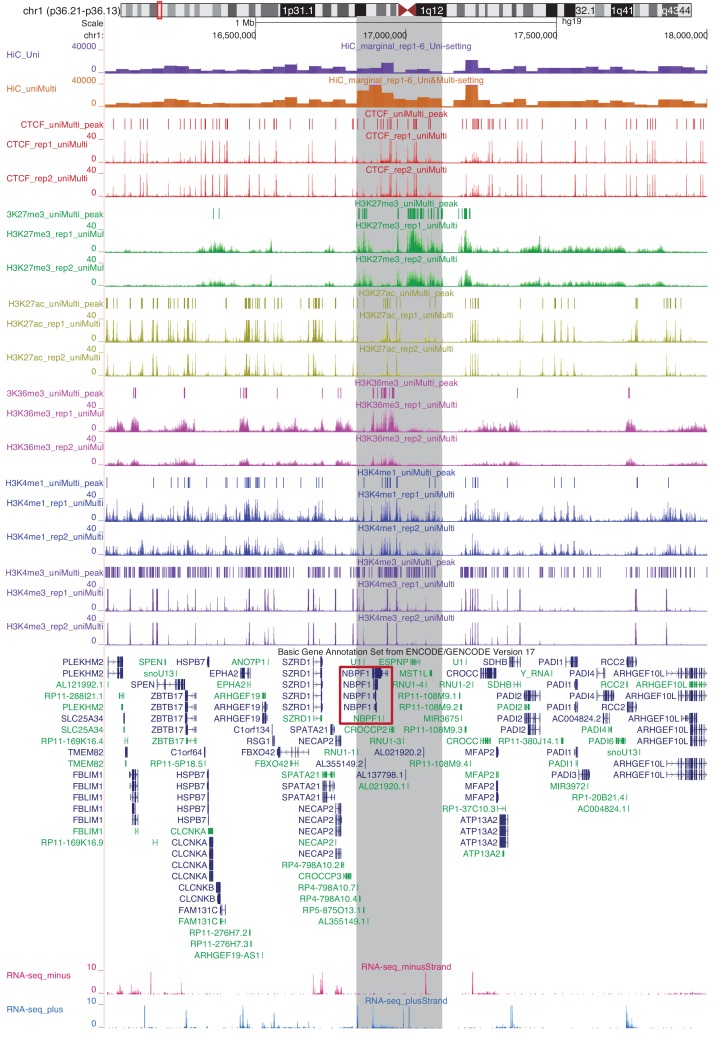
Marginalized Hi-C signal (contact counts aggregated across the genomic coordinates for six replicates of IMR90), ChIP-seq coverage and peaks and gene expression for chr1:16,000,000–18,000,000.Highlighted in grey is a region with significantly different marginal Hi-C signal between Uni-setting and Uni&Multi-setting.